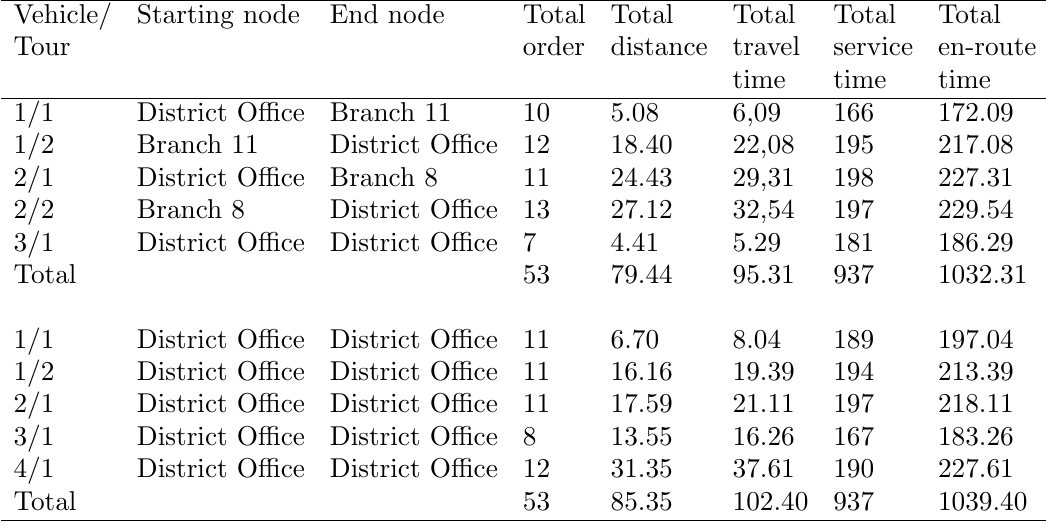
Table 5. The detailed results of instance GB-4.